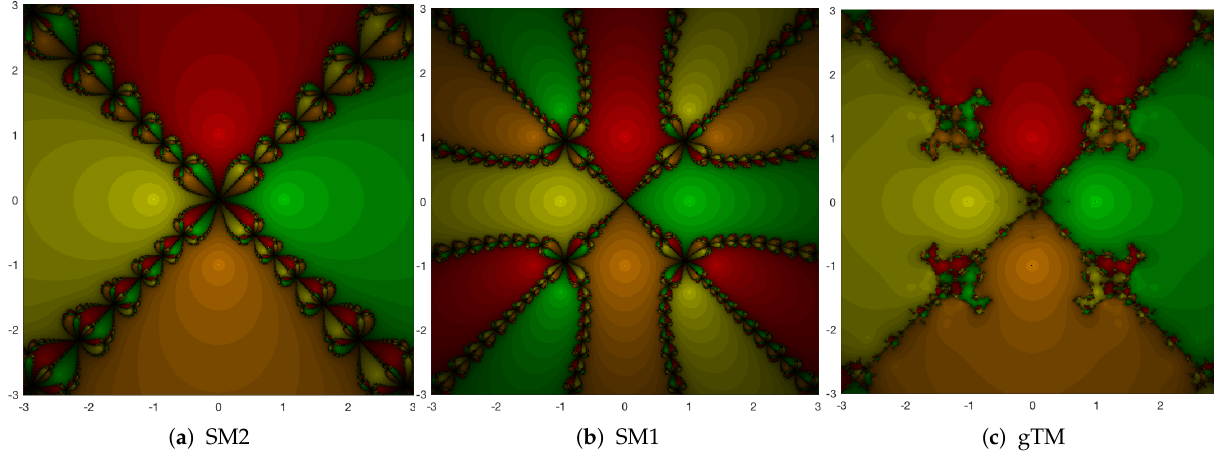
Figure 5. Dynamical planes of Schröder methods and gTM on f 3 ( x )